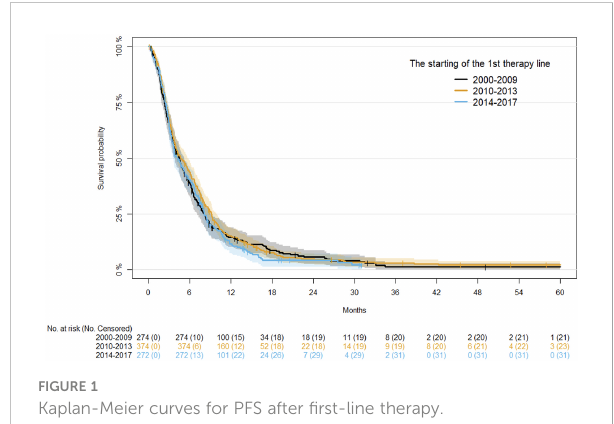
FIGURE 1 Kaplan-Meier curves for PFS after fi rst-line therapy.